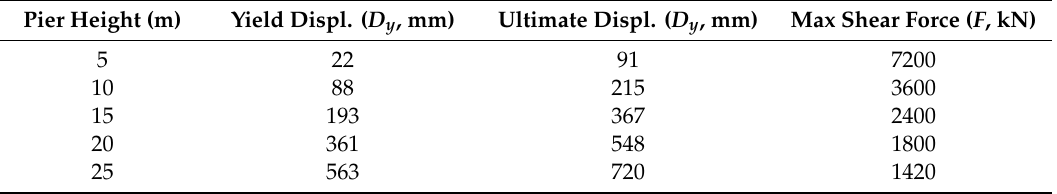
Table 4. Summary of the yield and ultimate displacements and the shear force for the piers of a bridge.